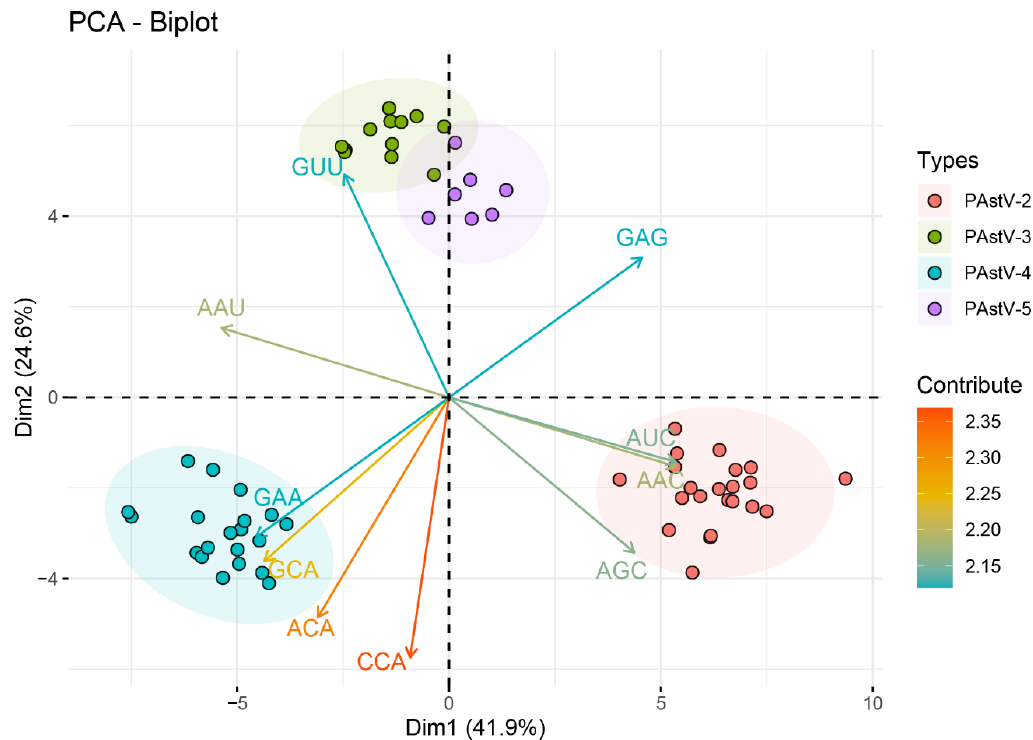
Figure 2. Principal component analysis (PCA) of the PAstV complete coding genomes. The first dimension was plotted against the second dimension. PAstV-2, PAstV-3, PAstV-4, and PAstV-5 are represented in orange, green, blue, and purple, respectively.